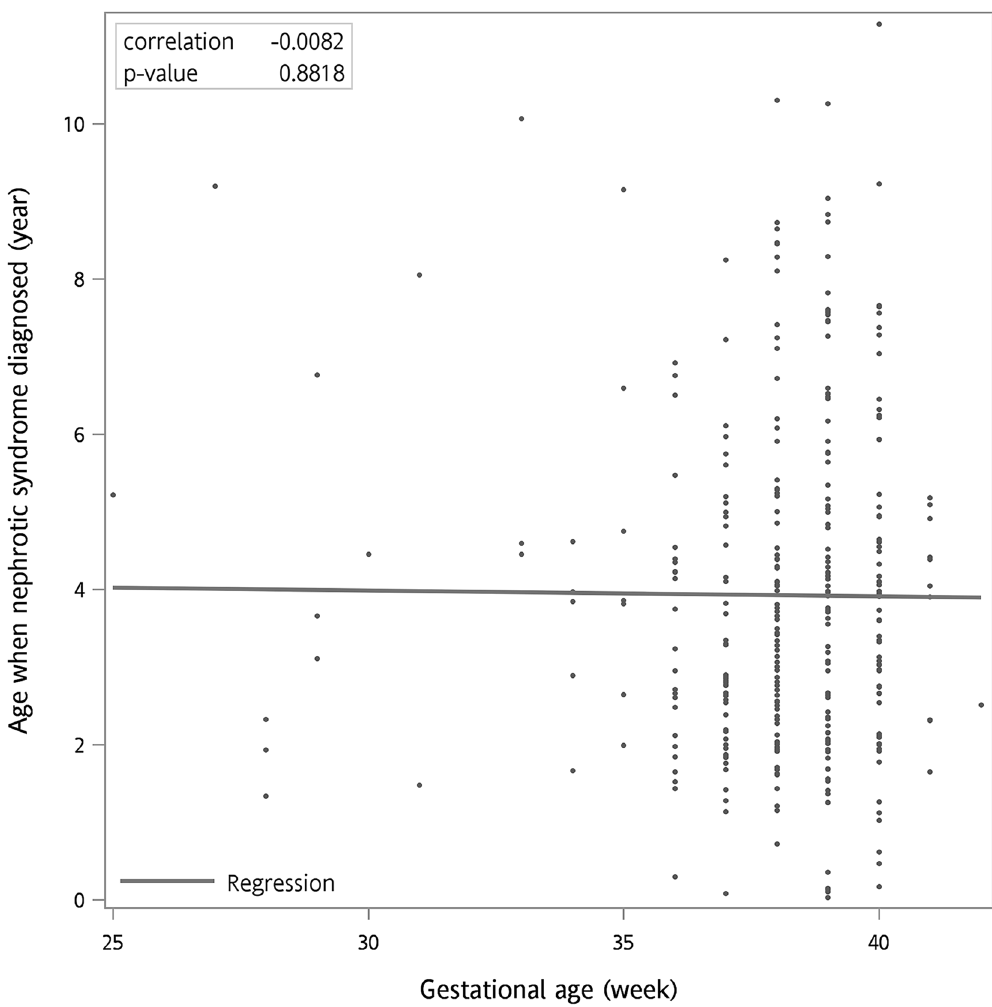
Figure 2. Relationships between gestational age and the age when nephrotic syndrome diagnosed. The Pearson correlation analyses showed that the correlation coefficient between gestational age and the age when nephrotic syndrome diagnosed was low.